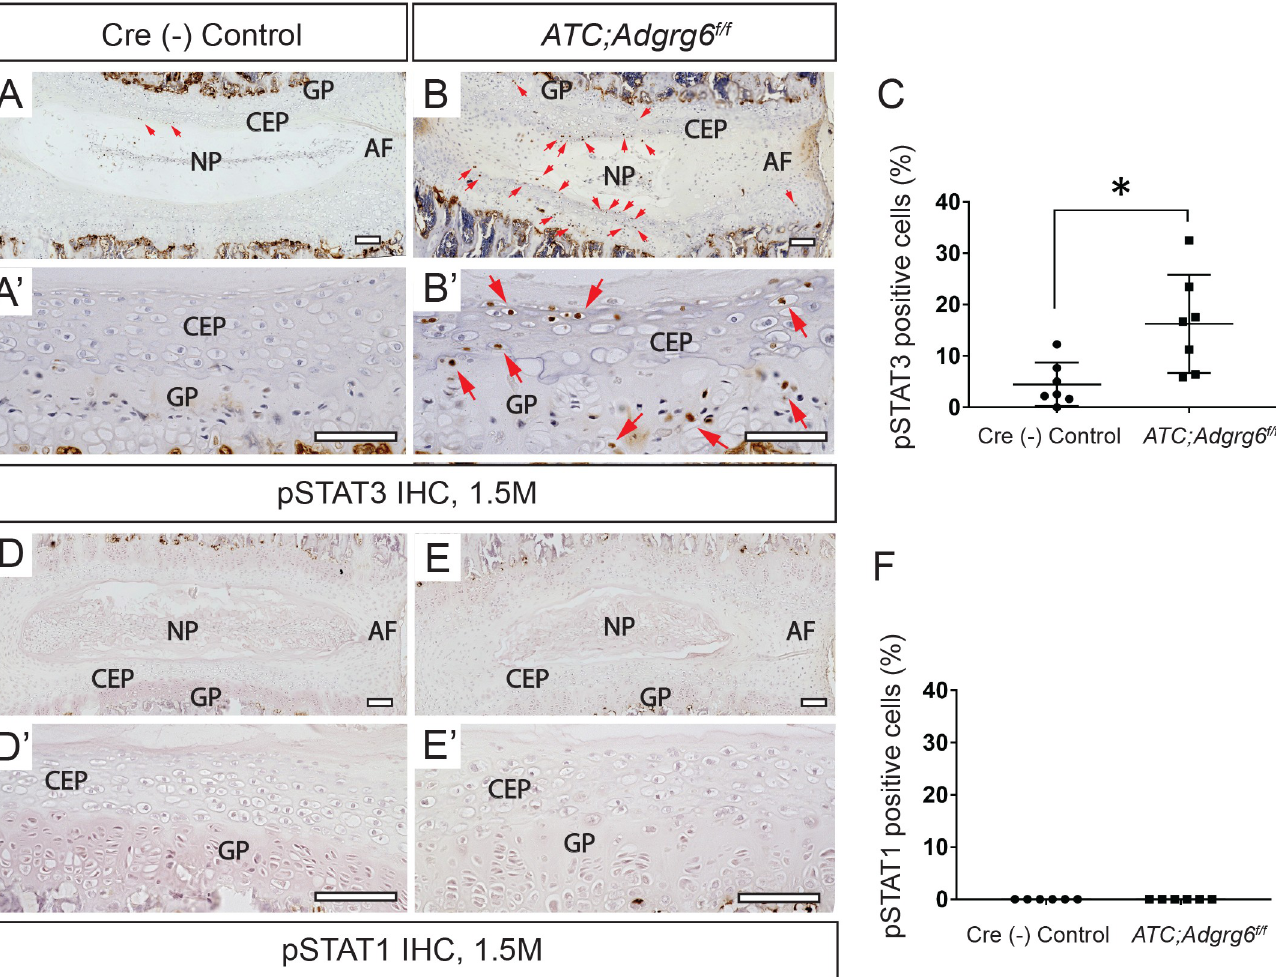
Fig 4. ADGRG6 regulates STAT3 signaling in IVDs. (A-B’) IHC analysis shows increased expression of pSTAT3 (red arrowheads, B, B’) in ATC;Adgrg6 f/f mutant mouse IVD at 1.5 months (induced from E0.5-P20, n = 3 for each group.) (D-E’) IHC analysis shows no signal of pSTAT1 in neither Cre(-) nor ATC;Adgrg6 f/f mutant mouse IVD at 1.5 months (induced from E0.5-P20, n = 3 for each group.) (C, F) Quantification of positive pSTAT3 (C) and pSTAT1 (F) cells in Cre(-) control or in ATC;Adgrg f/f mutant mouse IVDs. ( n = 3 mice for each group, at least two IVDs were scored for each mouse. Dots plot with mean ± SD. � p � 0.05, two- tailed Student’s t Test.) Scale bars: 200 μ m in (A, B), and 50 μ m in (A’, B’). CEP- cartilaginous endplate , GP- growth plate , and NP- nucleus pulposus